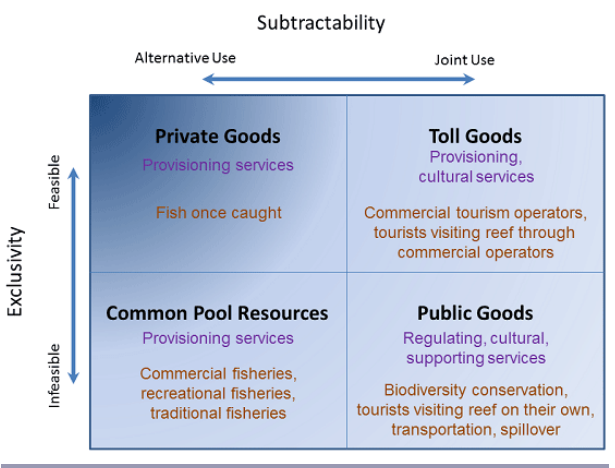
Fig. 2. Examples of activities and ecosystem services derived from different types of goods and ecosystem services in the Great Barrier Reef Marine Park. Black text, types of goods; purple text, ecosystem services; orange text, examples. Types of goods are delineated into four categories here but should be viewed as a